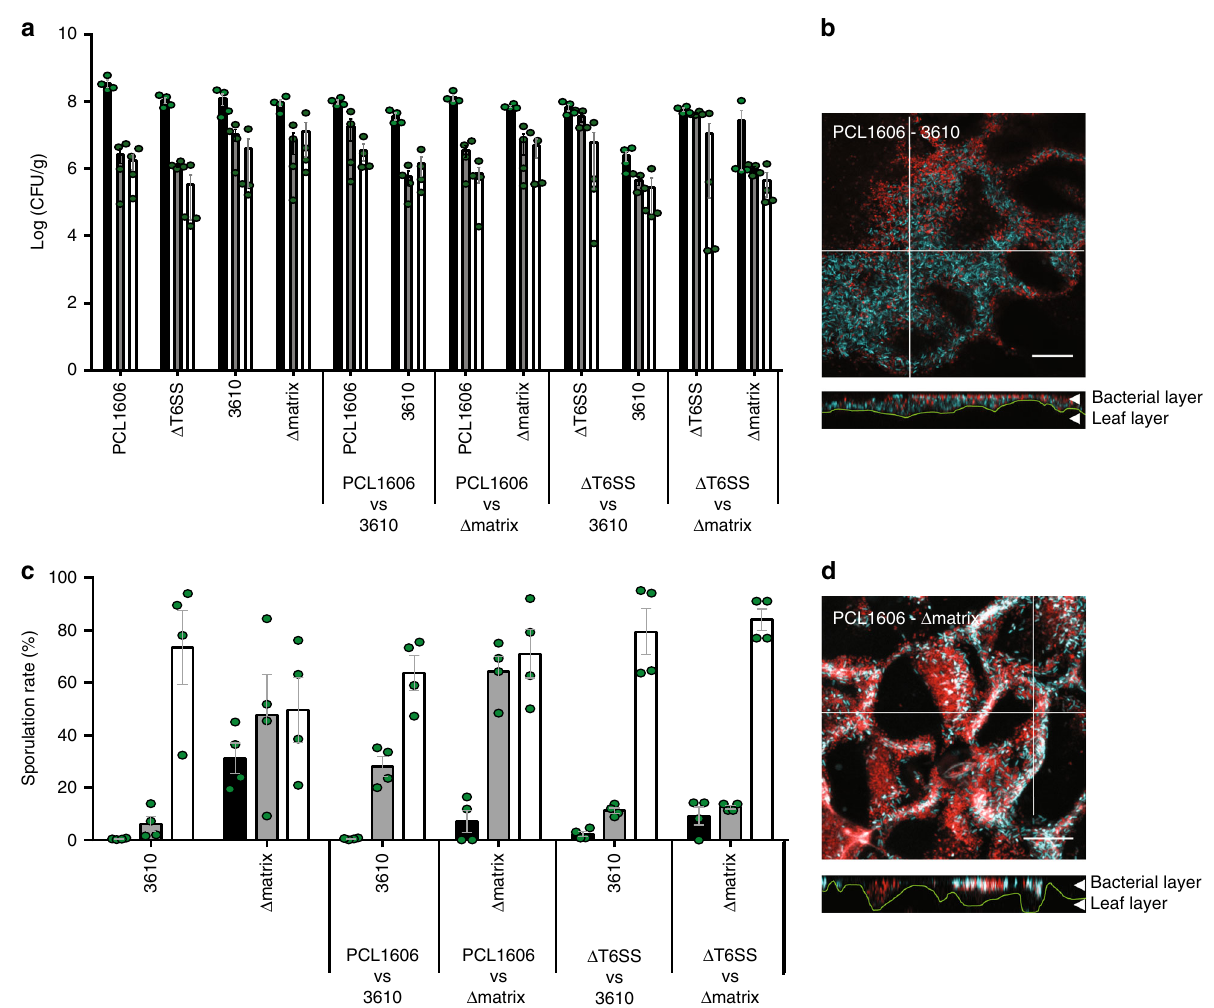
Fig. 8 The B. subtilis ECM facilitates interaction with PCL1606 on leaves. a Log (CFU/ml) of B. subtilis (3610 and Δ matrix) and P. chlororaphis (PCL1606 and Δ T6SS) strains after single- and co-inoculation of melon leaves. b Sporulation percentages of Bacillus subtilis species after single- and co-inoculation of melon leaves. Colony-forming units and spore percentages were counted at 0 dpi (black bars), 2 dpi (gray bars), and 9 dpi (empty bars). Average values of four biological replicates are shown, with error bars representing SD. * P value < 0.05, ** P value < 0.01, *** P value < 0.001 (Tukey test). c , d CLSM maximum projections and z axis slices at positions indicated by the white lines of the interactions between c 3610 – PCL1606 (top) and d Δ matrix – PCL1606 (bottom) after 9 days of co-inoculation. Bacillus strains were labeled with CFP and PCL1606 was labeled with DsRed. Bacterial and leaf layers are indicated with arrows. Green lines indicate the leaf surface. White color is the consequence of the overlap between the fl uorescence of PCL1606 and Bacillus strains. Scale bar, 100 µ m. Source data are provided as a Source Data fi